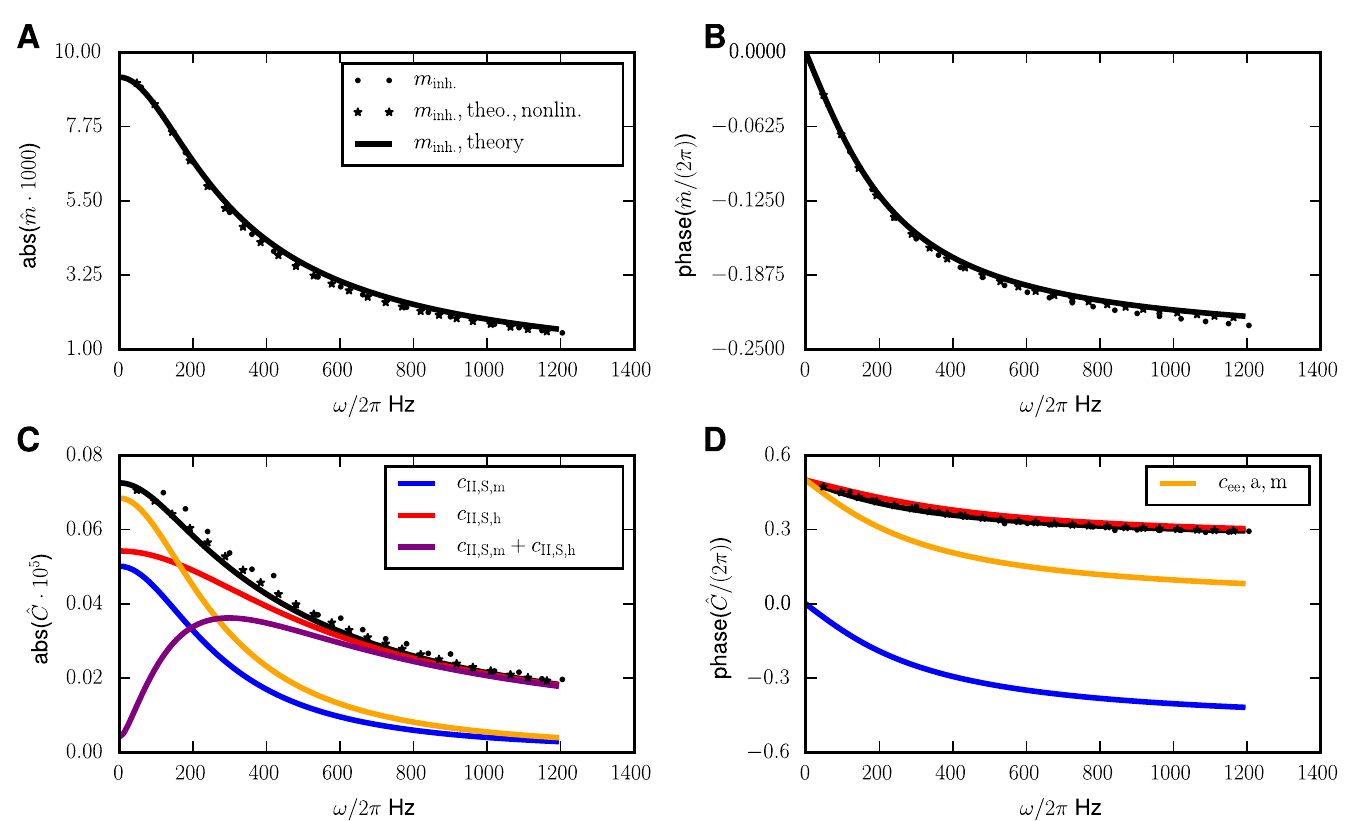
Fig 3. Periodically driven single population network. Dependence of the modulations of the mean activity and covariances on the driving frequency ω . A Amplitudeof modulationof mean activity. B Phase of modulationof mean activity relativeto the external drive. C Amplitude of modulation of covariances. D Phase of modulation of covariancerelative to the external drive. In all panels,the analyticalpredictions(Eqs (9) and (39)) are shown as solid black curves. The black curve is the completesolution. The different contributions to the time-dependent covariances, identifiedin Eq (12), are shown separately: The S h -term in red, the S m -term in blue, their sum in purple, and the a -term in orange. Numericalsolutionsof the full mean-field equations(Eqs (5) and (6)) are shown as stars and simulationresults by dots (only indicatedin the legendof A). The numerical results are obtainedby using the integrate. ode-method from the python-package scipy [41] with the option“lsoda”, meaningthat either implicit Adams- or backwarddifferentiation-algorithms (dependingon the given problem)are used. Network parameters: Number of neurons N I = 5000, connectionprobability p II = 0.1, couplingstrength J II = − 1, ffiffiffiffiffiffiffiffiffiffiffiffiffiffiffiffiffiffiffiffiffiffiffiffiffiffiffiffiffiffiffiffiffiffiffiffiffi p ¼ s ð 1 (cid:0) m Þ (cid:25) 10 : 2 J 2 p N m mean activity m I (cid:25) 0.3, and s ≔ noise system II II I I I